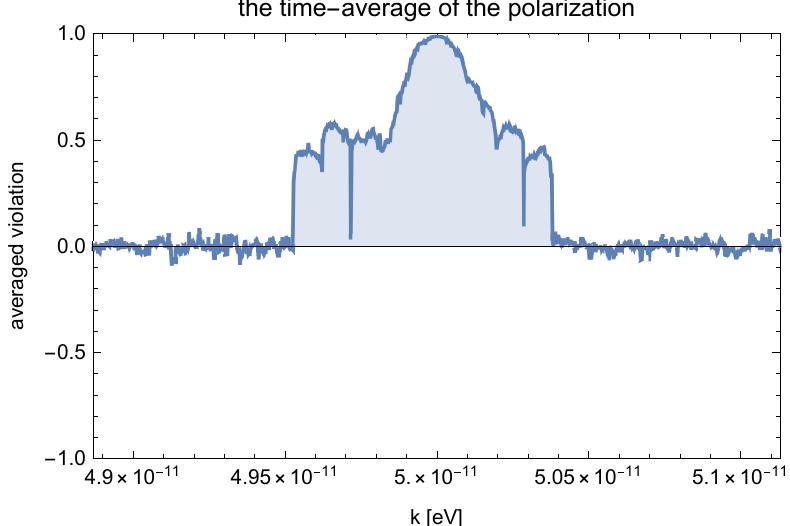
Figure 1. The degree of the circular polarization is plotted for (cid:96) = 10 8 km, m = 10 − 10 eV, ρ = 0.3GeV/cm 3